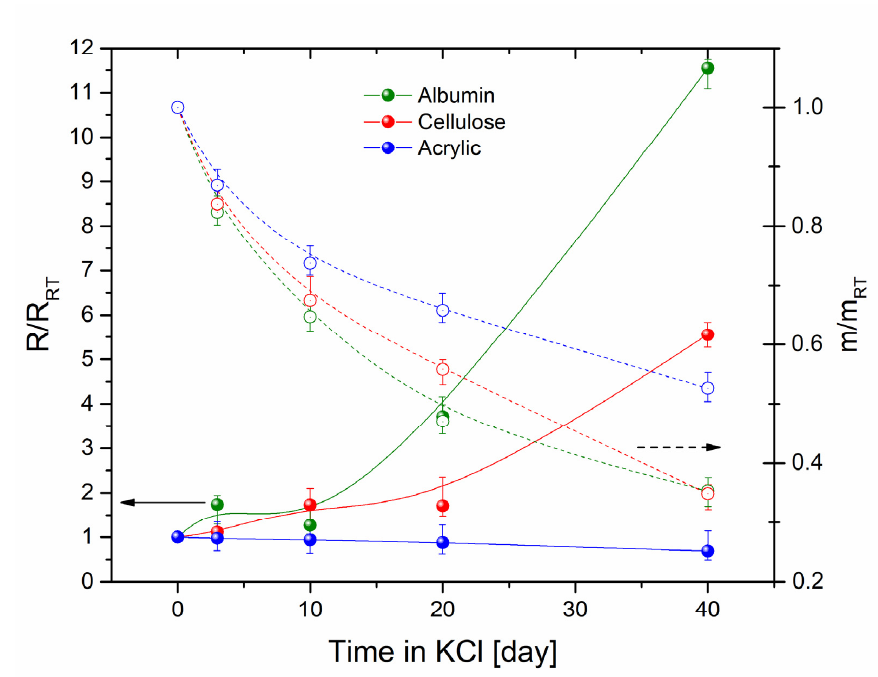
Figure 4. Stability test of albumin (green), cellulose (red) and acrylic polymer (blue)-based composites mixed with 0.45 wt.% nanotubes in 0.1 mM KCl electrolyte showing changes of the normalized resistance (R / R RT ) (left scale, straight lines) and the normalized mass (m / m RT ) of deposited composites (right scale, dashed lines). R RT and m RT are initial resistance and mass values used for normalization,